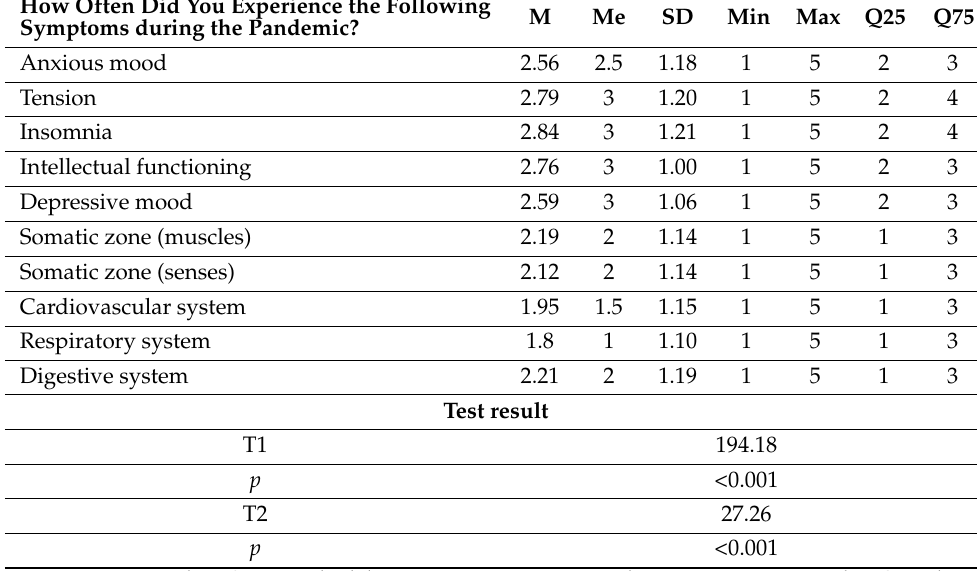
Table 4. Somatic and psychosomatic symptoms reported by the